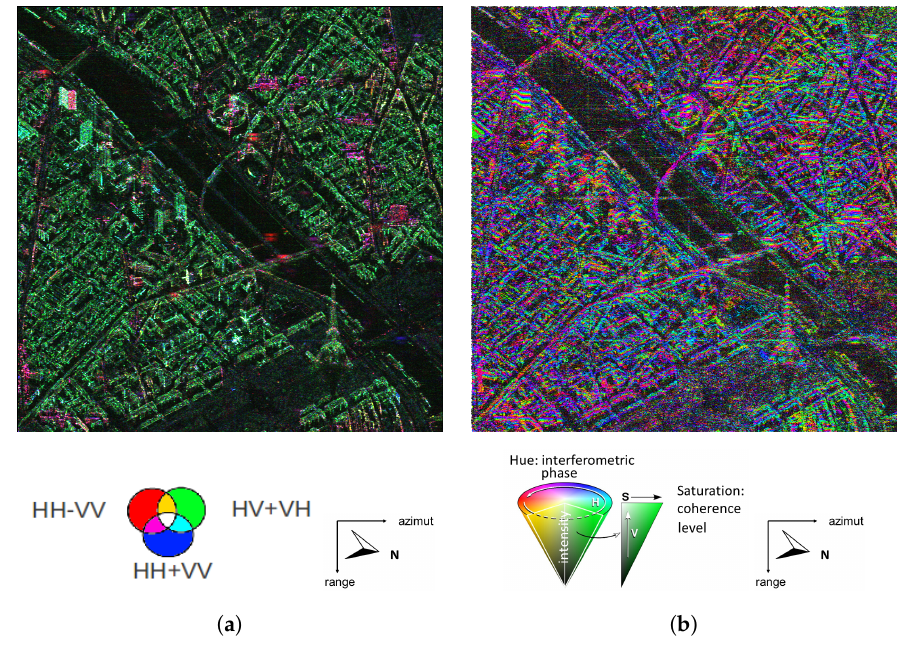
Figure 8. ( a ) Polarimetric image in the Pauli basis; ( b ) interferometric image on the right in the HSV color